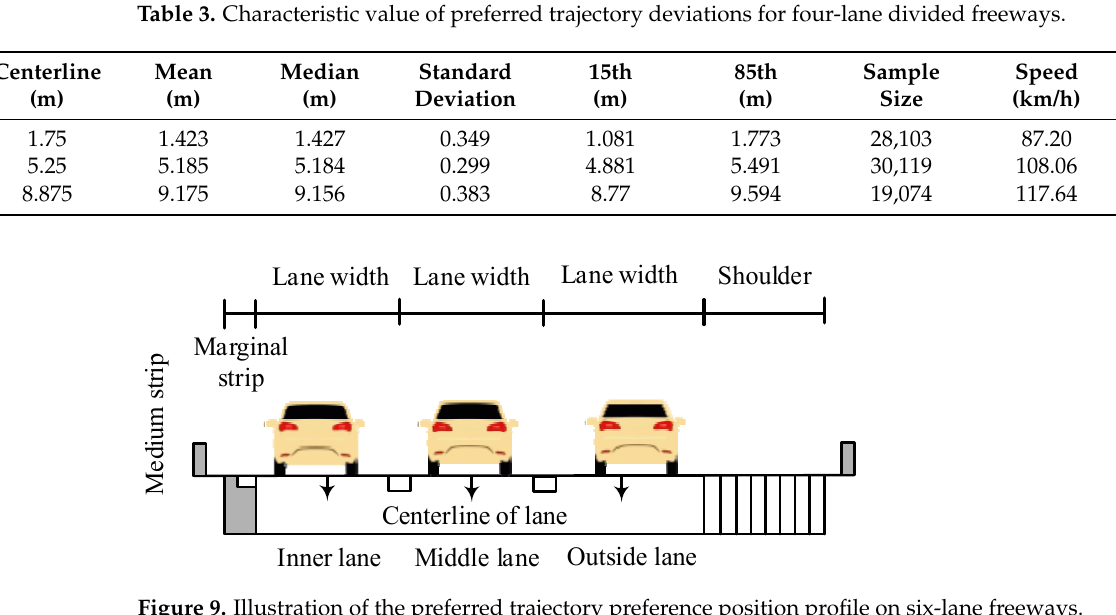
Figure 9. Illustration of the preferred trajectory preference position profile on six-lane freeways. The dispersion of the outside lane of the six-lane divided freeway road (3.75 m) is greater than that of the inner and middle lanes (3.5 m). The dispersion degree of the middle lane is smaller than that of the inner lane, indicating that the wider the lane, the more lateral space is provided for vehicles, and the dispersion degree of the trajectory will also